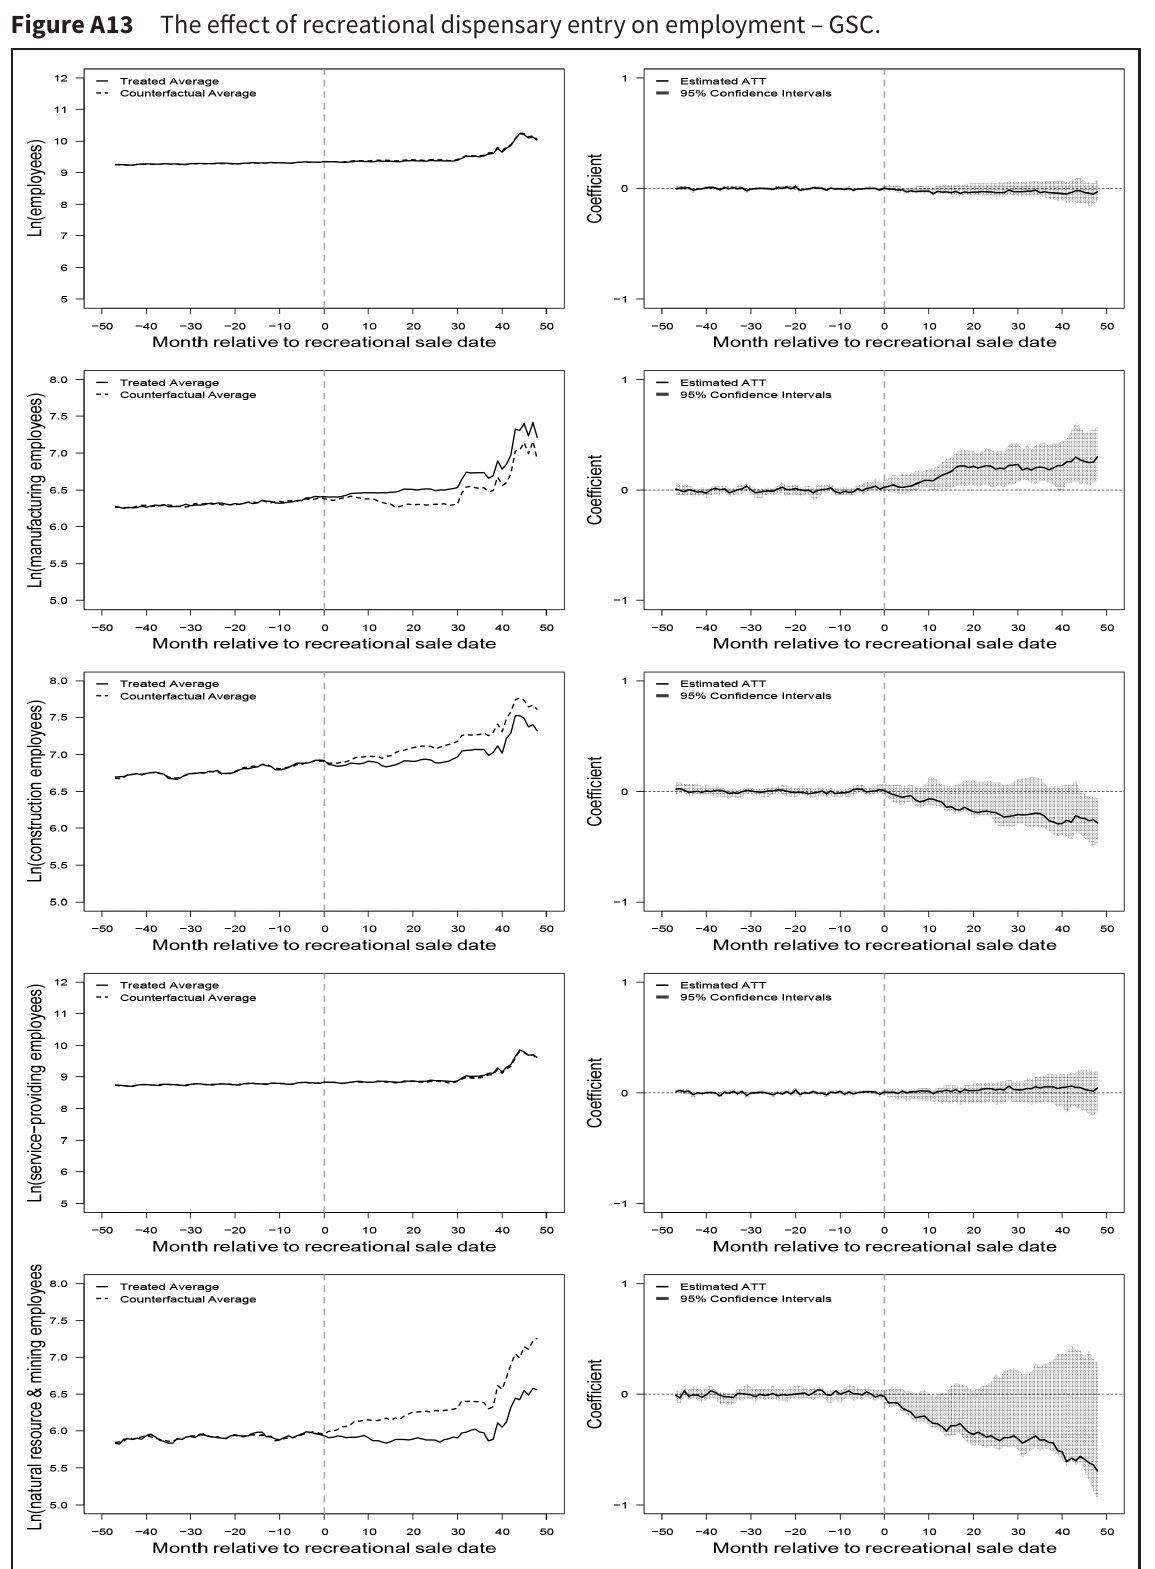
The effect of recreational dispensary entry on employment –